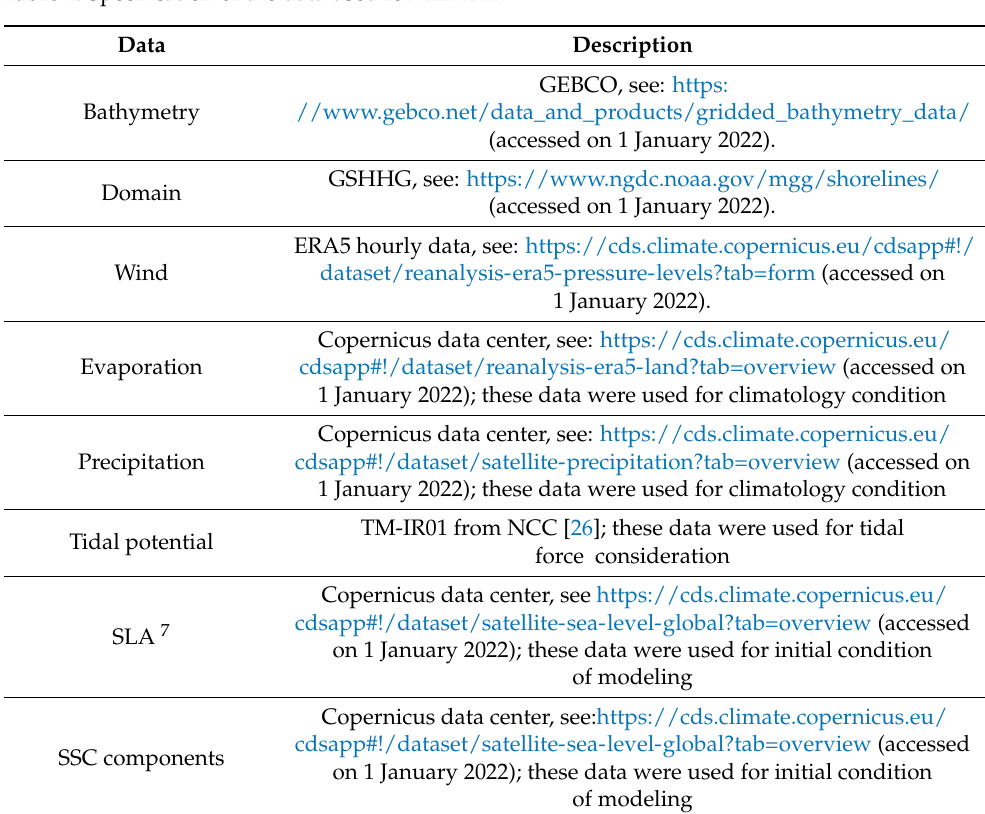
Table 4. Specification of the data used for MIKE